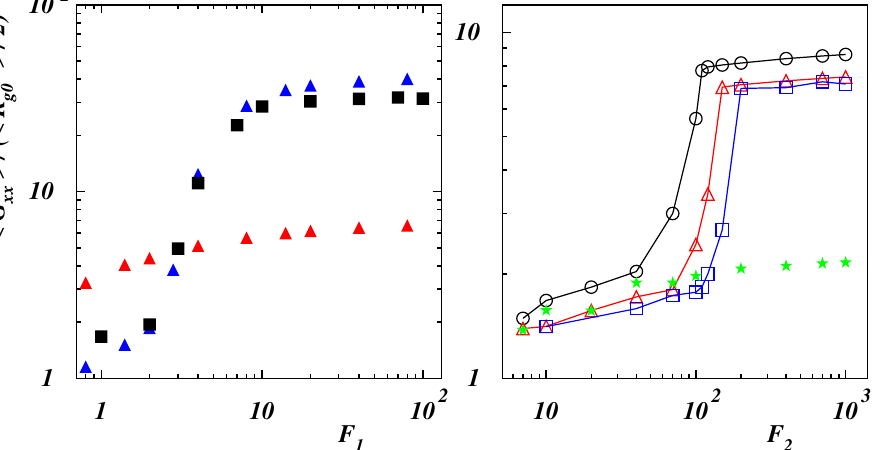
Figure 7. ( Left panel) Radius of gyration tensor component along the force direction with respect to the equilibrium value as a function of the dimensionless force F 1 = NFr 0 / ( k B T ) for L p / L = 0.1 (blue filled triangles), 0.2 (black filled squares) with (cid:101) / ( k B T ) = 2, and for L p / L = 0.1 (red filled triangles) with (cid:101) / ( k B T ) = 0.25. ( Right panel) Radius of gyration tensor component along the force direction with respect to the equilibrium value as a function of the dimensionless force F 2 = NFL p / ( k B T ) for L p / L = 0.4 (black open circles), 0.6 (red open triangles), 0.8 (blue open squares), and 2 (green filled stars) with (cid:101) / ( k B T ) = 2.